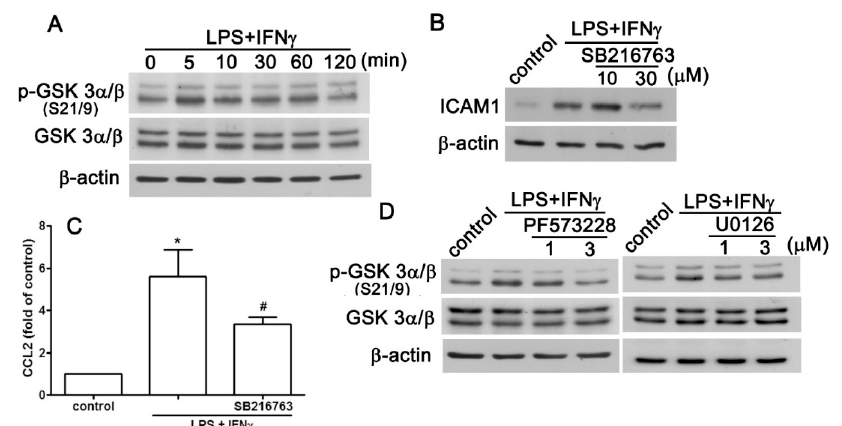
Figure 4. GSK3 is involved in the pro-inflammatory stimuli-associated expression of ICAM1 and CCL2 in human AF cells. ( A ) Cells were treated with LPS plus IFN γ for 5, 10, 30, 60, or 120 min, and phosphorylated GSK 3 α / β expression were determined using western blot analysis. Cells were treated with the GSK3 inhibitor; SB216763, for 30 min and stimulated with LPS plus IFN γ for another 6 or 24 h. ICAM1 ( B ) and CCL2 ( C ) expression were determined using western blot analysis and real-time PCR analysis, respectively. ( D ) Cells were treated with the FAK inhibitor PF573228 (left panel), or MEK inhibitor U0126 for 30 min and then treated with LPS plus IFN γ for another 60 min, and phosphorylated GSK 3 α / β expression was determined using western blot analysis. Quantitative data are presented as the mean ± SEM (representative of n = 3). * p < 0.05 compared with the control group. # p < 0.05 compared with the LPS/ IFN γ treatment group.